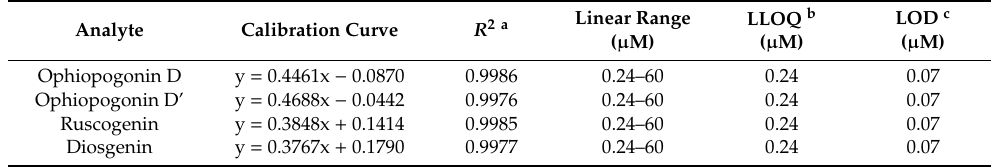
Table 2. Linearity and sensitivity of UPLC-MS / MS assay for ophiopogonins in fermented broth of human gut microbiota.